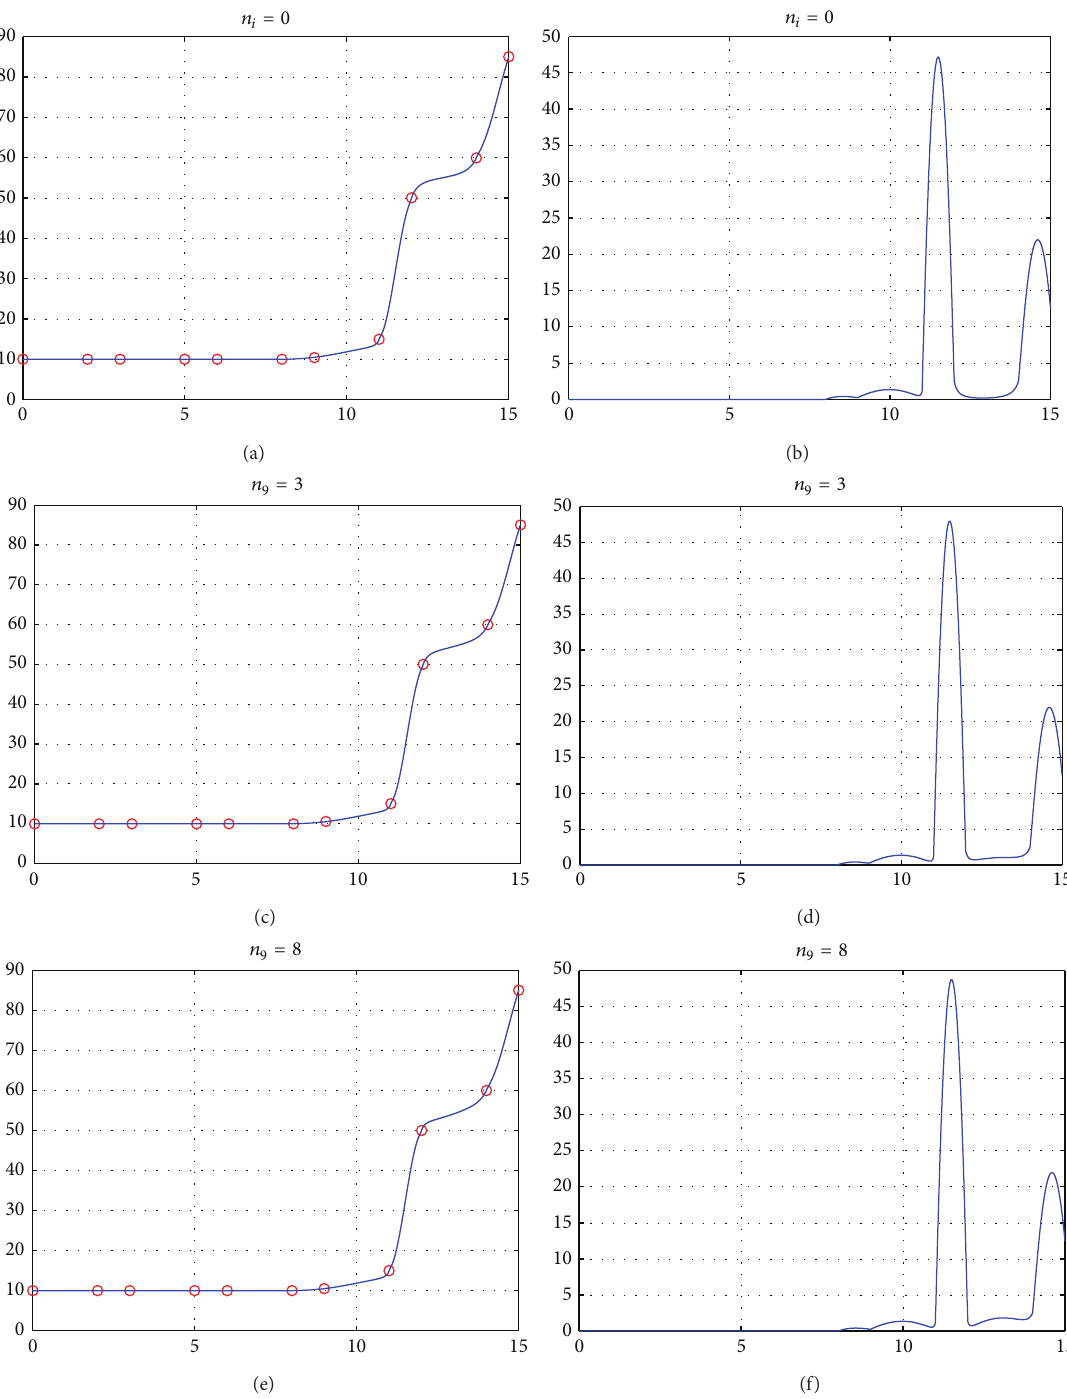
Figure 8: Monotonicity-preserving interpolation spline curves for the Akima’s data given in Table 3 and the graphics of their first